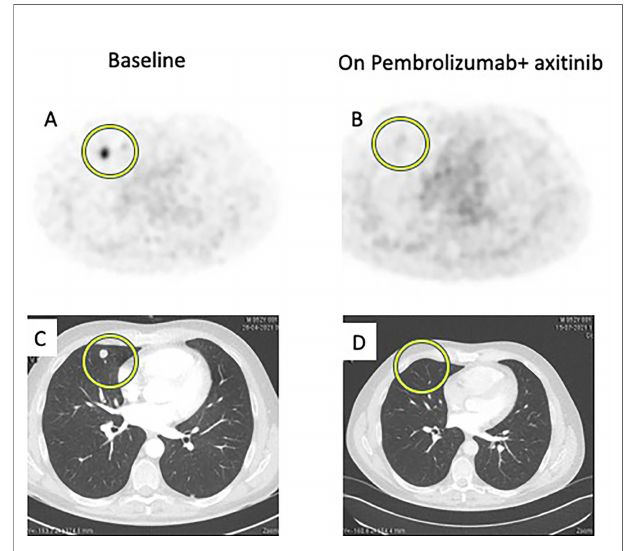
FIGURE 1 | Comparison between baseline imaging and on-treatment imaging. 68 GaPSMA-PET at baseline (A) and at 8-week (B) showing decrease of metabolism (yellow circle). Thoracic CT Scan at baseline (C) and at 12-week (D) showing disappearance of pulmonary lesions (yellow